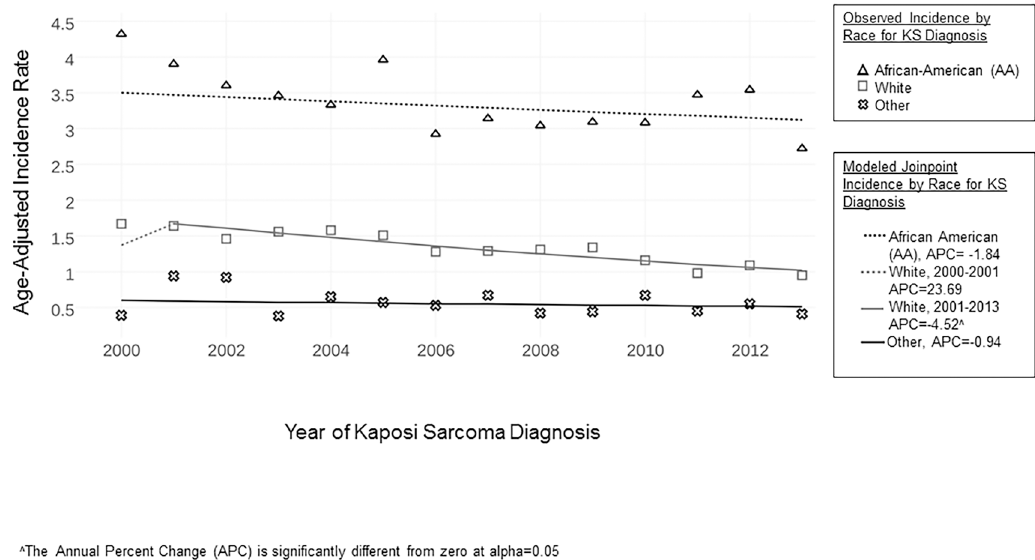
Fig 3. KS incidence in the U.S. by race,